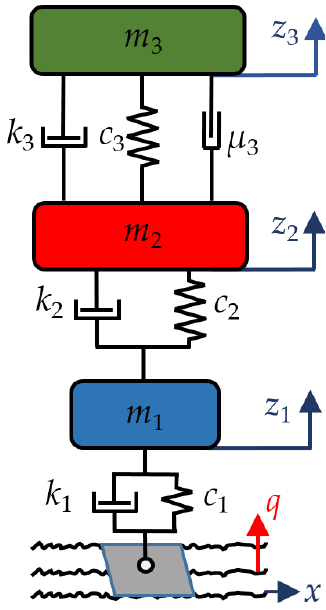
Figure 9. Quarter-car model.